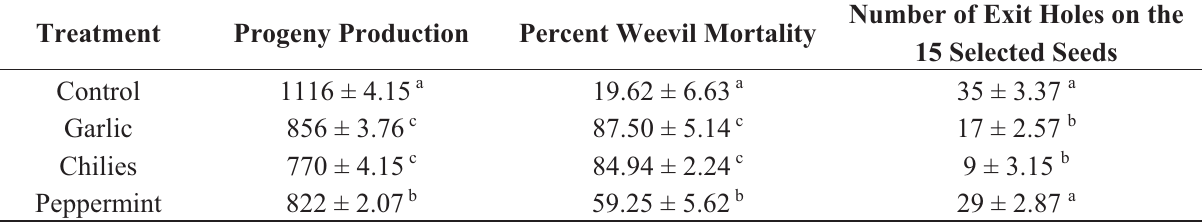
Table 2. Effects of natural plant products on progeny production, weevil mortality and number of exit holes on cowpea seeds.